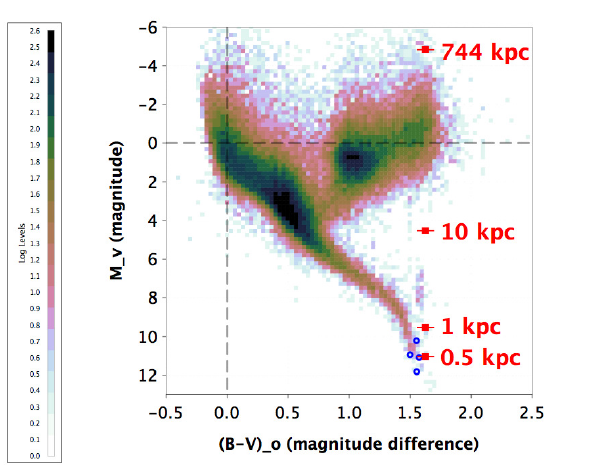
Figure 7. Example 2D histogram plot made by Thoth (in astronomy, this is an example of a Hess diagram; see text for details about the graph data, from Soraisam et al. [6]). The graph includes labels and markareas in red and blue, and marklines in black. The gradated colors are from the cubehelix color table. The intersection of black-dashed marklines indicate the graph